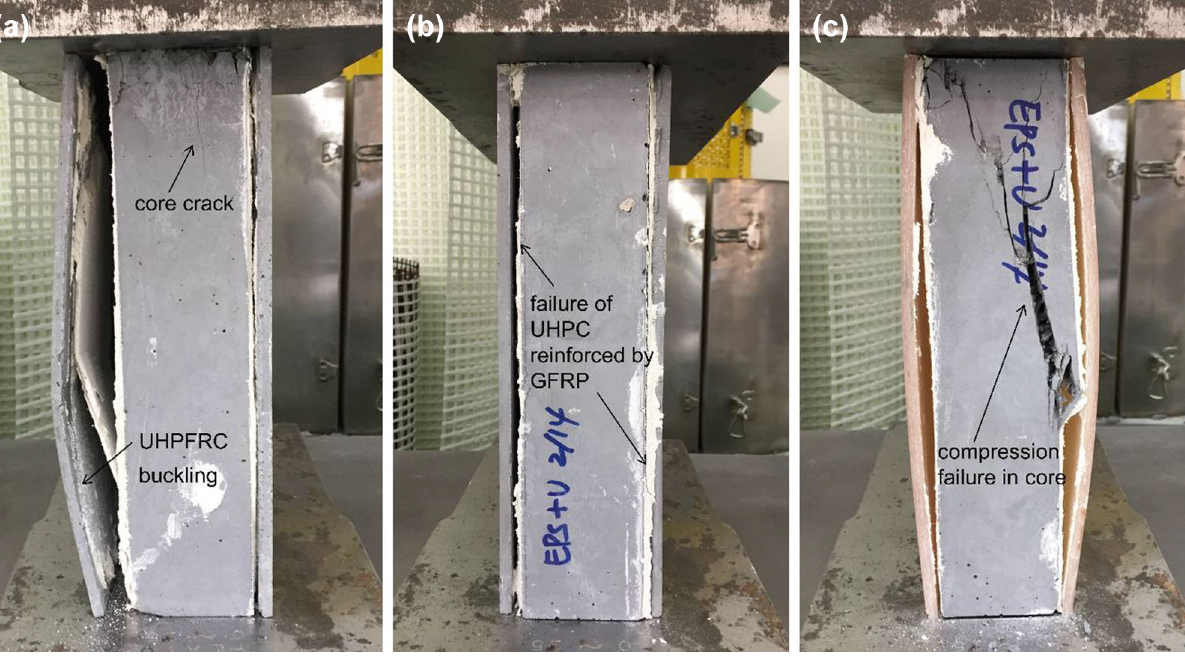
Fig. 8 Edgewise compression test results for the specimens with HPEPC core; a U-U1 specimen, b U-U2 specimen, and c U-G specimen.